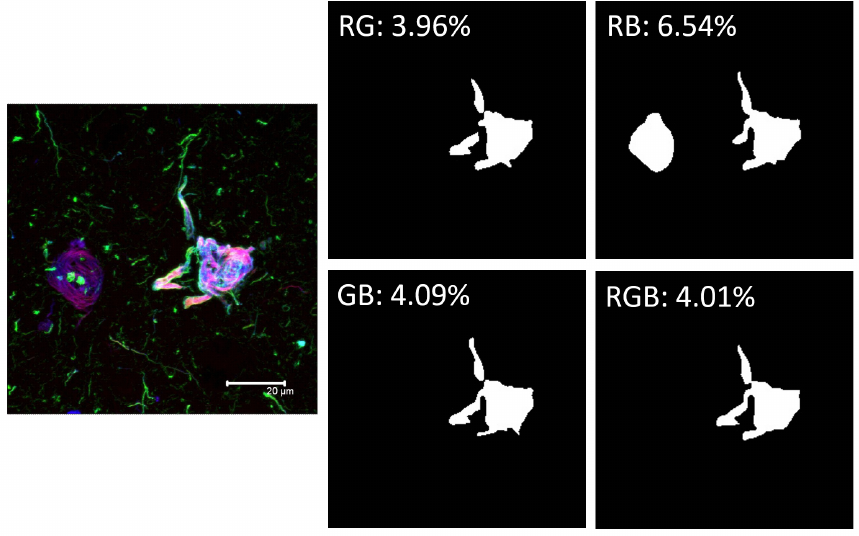
Figure 6. Quantification of the fluorescent signal using the proposed model. The quantification consists of counting the number of pixels in the segmented regions and dividing that number by 65,536, the total pixel count in a 256 × 256 pixel image. R: red; G: green; B: